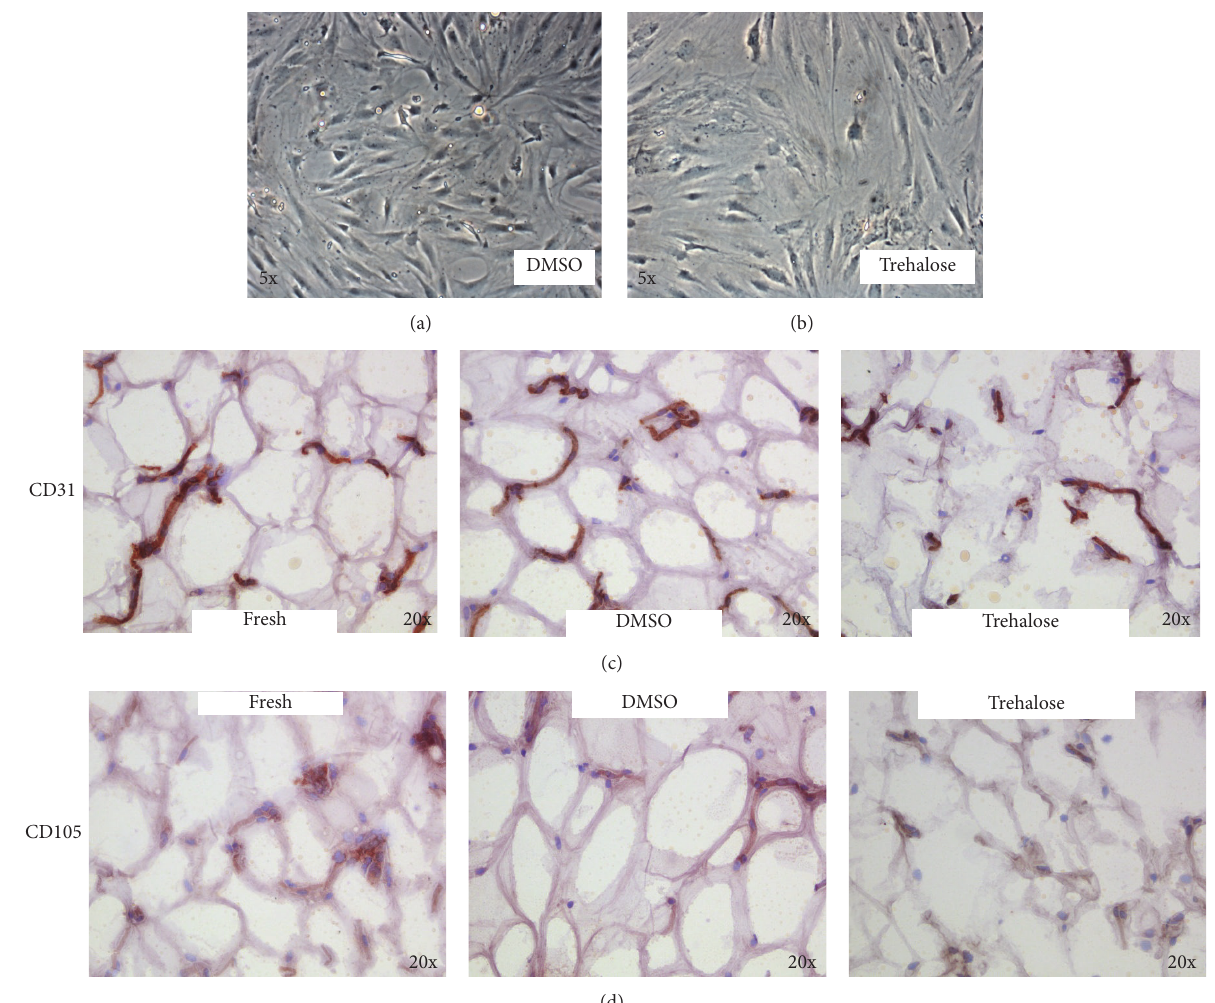
Figure 3: DMSO cryopreserved adipose tissue better than trehalose. ATD-MSCs isolated from DMSO cryopreserved lipoaspirates showed a better morphology compared with trehalose ((a) and (b)). The IHC staining for CD31 (line (c)) and CD105 (line (d)) showed that the different cellular structures were better preserved in samples cryopreserved with DMSO than with trehalose.